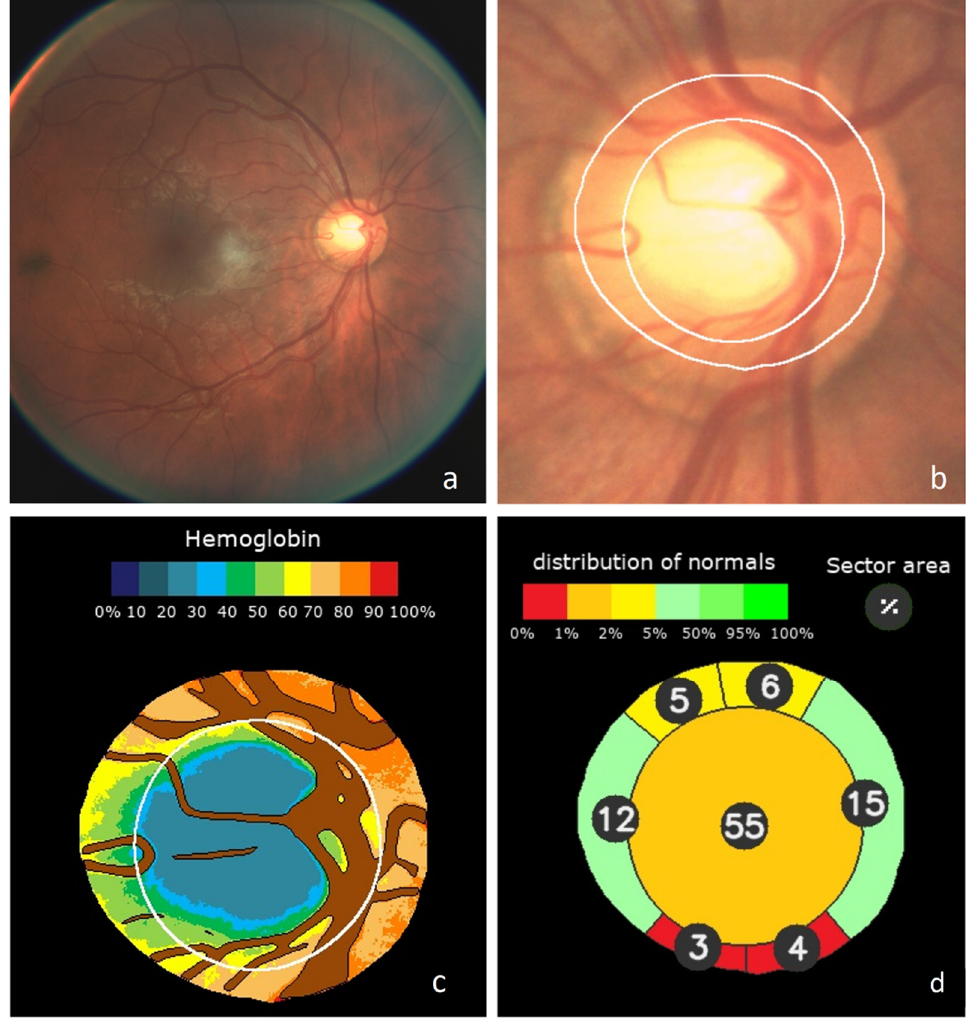
Figure 1. Example of Laguna ONhE analysis: ( a ) Original wide-field eye fundus image. ( b ) Identifi- cation of the optic disc and boundaries segmentation. Central cup estimated from the haemoglobin distribution. ( c ) Segmentation of reference vessels and pseudo-colour image of haemoglobin distri- bution. ( d ) Estimated sector areas as a percentage of the total area, and compared to a normal refer- ence population.